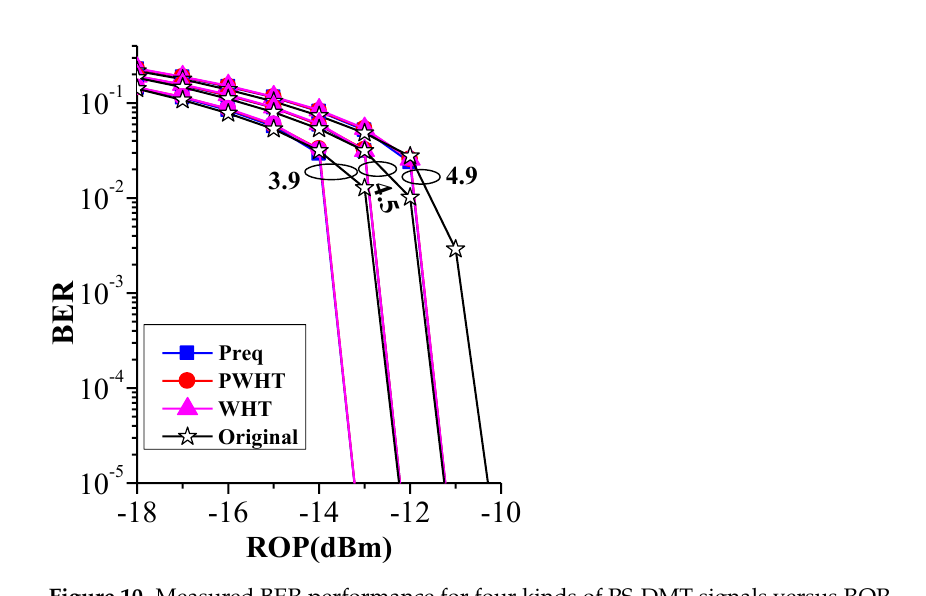
Figure 10. Measured BER performance for four kinds of PS-DMT signals versus ROP.